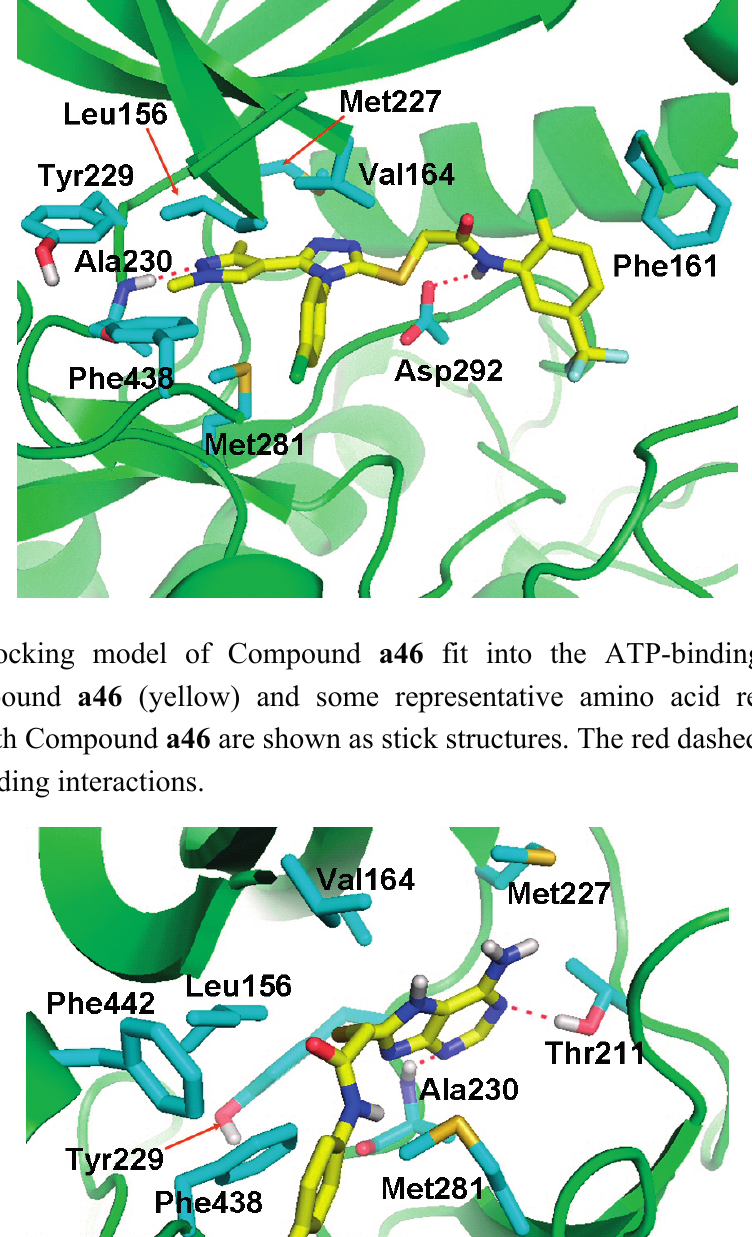
interactions with surrounding residues, including Leu156, Val164, Met227, Tyr229, Phe237, Met281, Phe438 and Phe442.